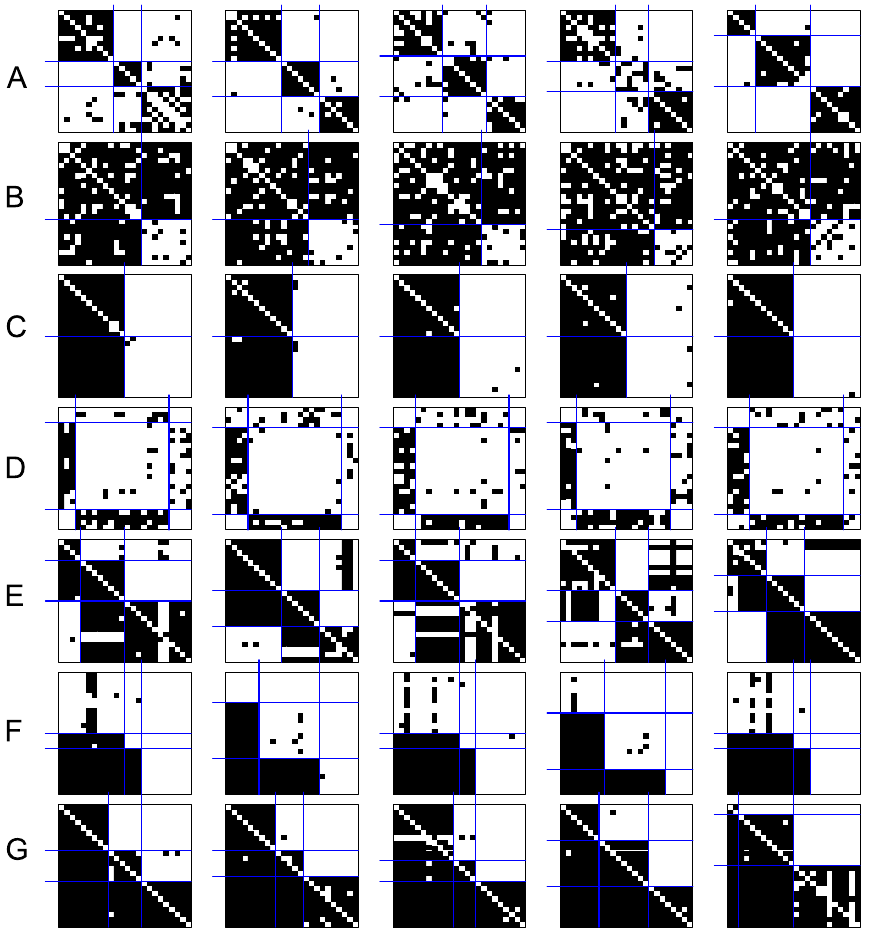
Fig 7. Some empirical generated networks using the RL algorithm by considering all triad types. By rows: (A) cohesive; (B) symmetric core-periphery; (C) asymmetric core-periphery; (D) hierarchical without complete blocks on the diagonal; (E) hierarchical with complete blocks on the diagonal; (F) transitivity without complete blocks on the diagonal; (G) transitivity with complete blocks on the diagonal.